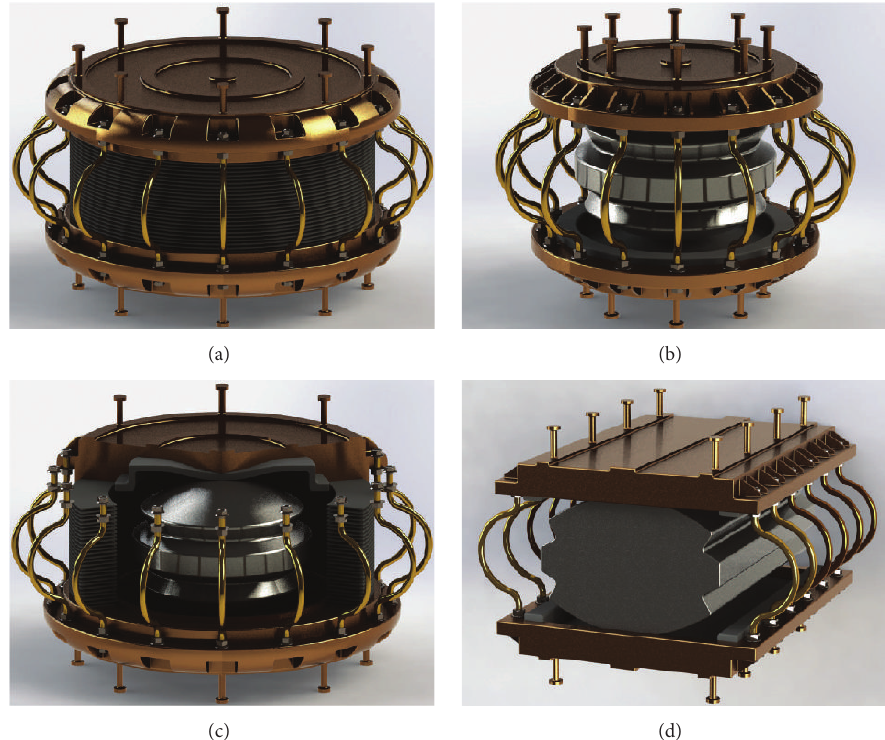
Figure 7: The RNC isolator designs for (a) a multidirectional/heavy-loads; (b) a multidirectional/light- to moderate-loads; (c) sectional view of the multidirectional/heavy-loads; (d) a unidirectional/light- to